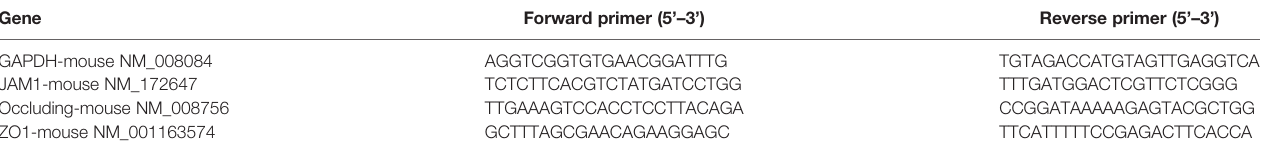
TABLE 1 | Primer sequences used in this